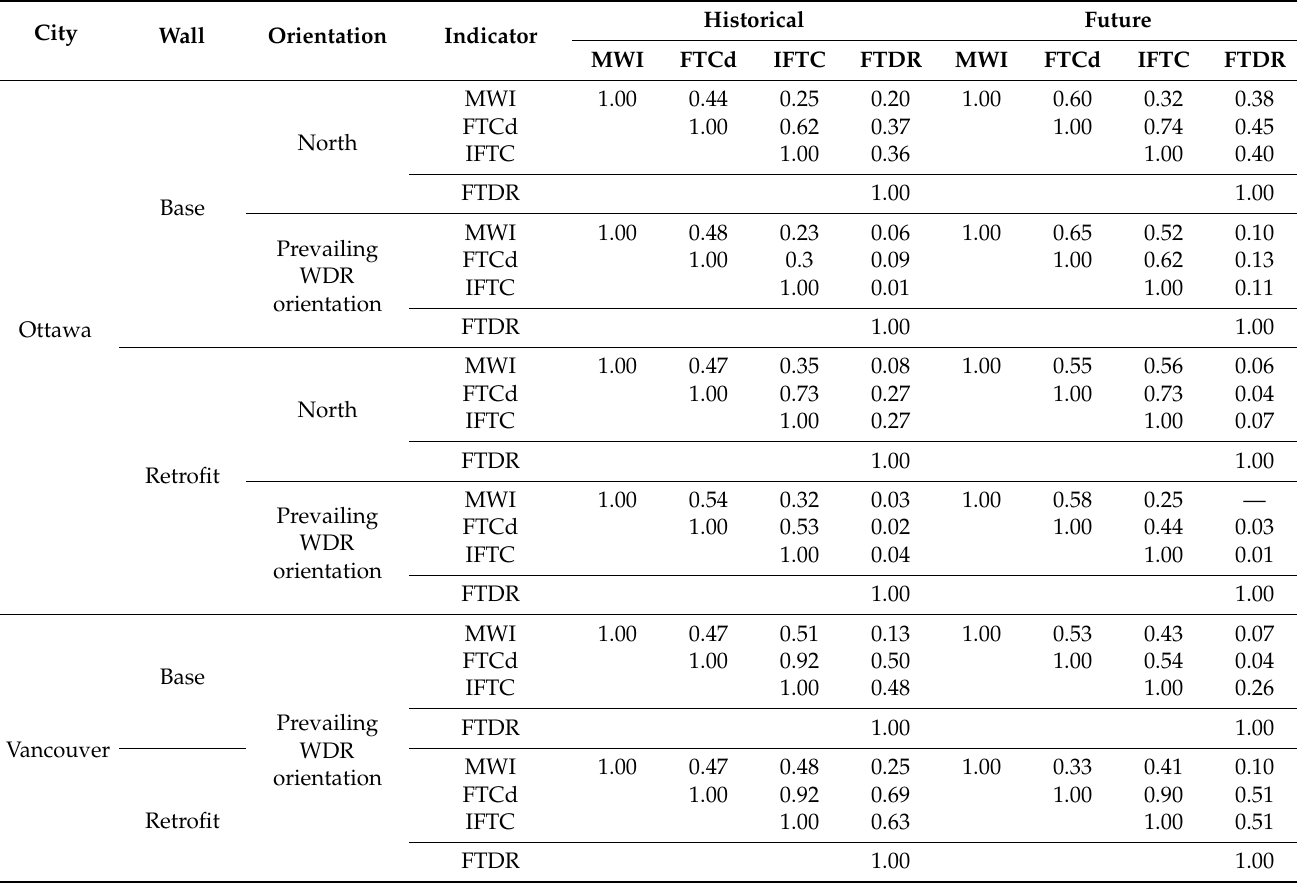
Table 7. Coefficient of determination (R 2 ) among different response-based indices for all the simulated cases for a solid brick in its original state and after being retrofitted, in Ottawa and